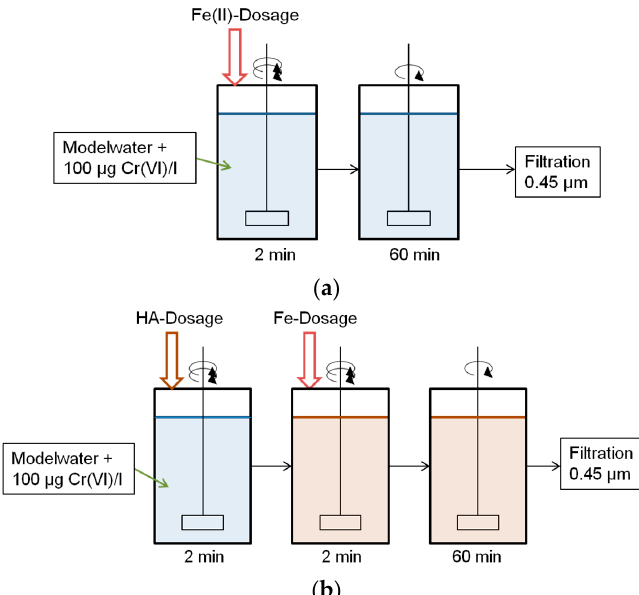
Figure 1. Jar test procedure for both experimental set-ups; ( a ) Procedure without the presence of humic acids (Has): 2 min of rapid stirring, followed by 60 min of slow stirring; ( b ) Procedure with the